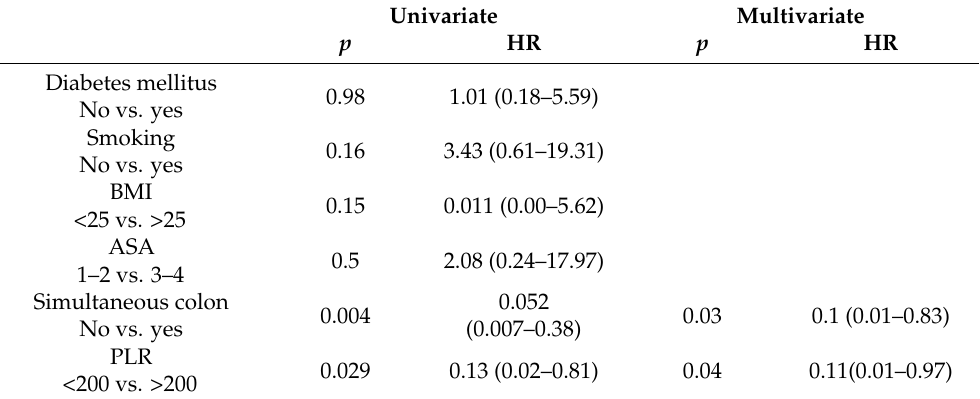
Table 3. Univariate and multivariate cox regression